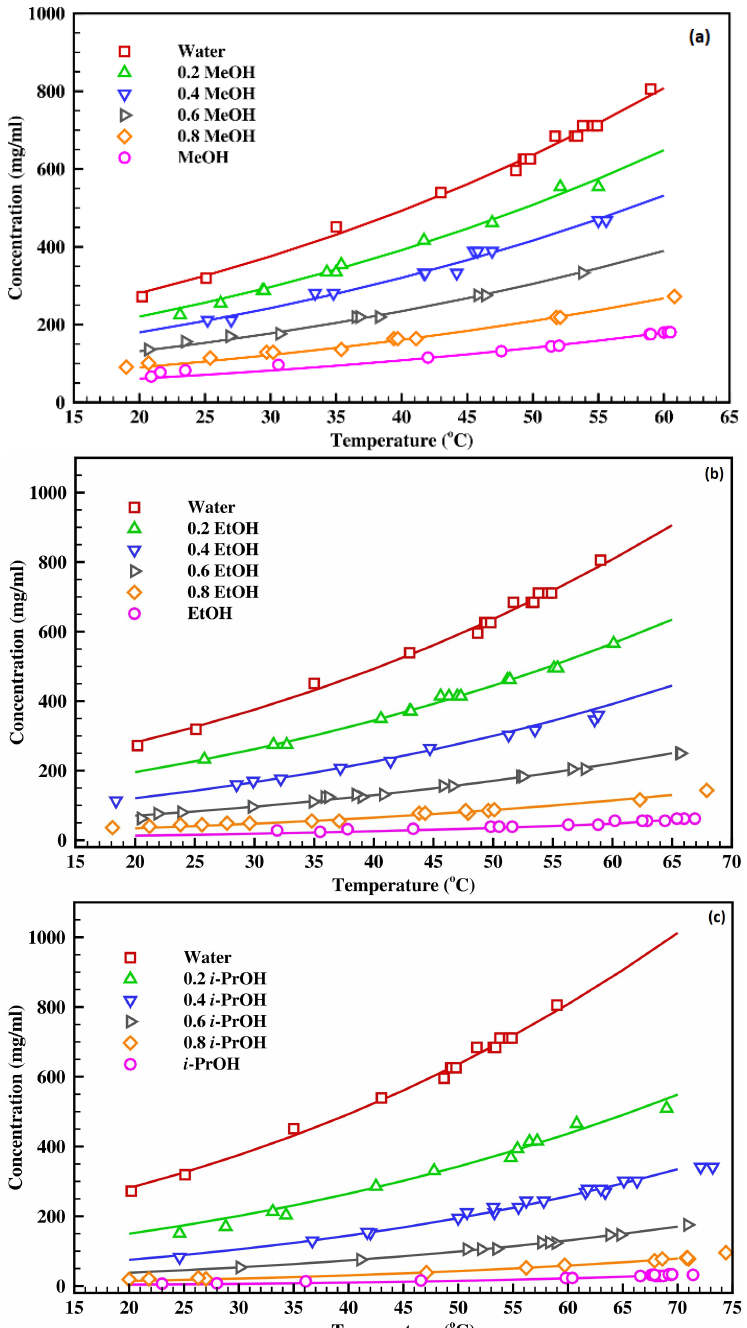
Figure 4. Solubility of ascorbic acid in binary solvent systems ( a ) Water-Methanol, ( b ) Water-Ethanol and ( c ) Water-Isopropanol. Symbols represent the clear points and solid line represents the Van’t Hoff equation (Equation